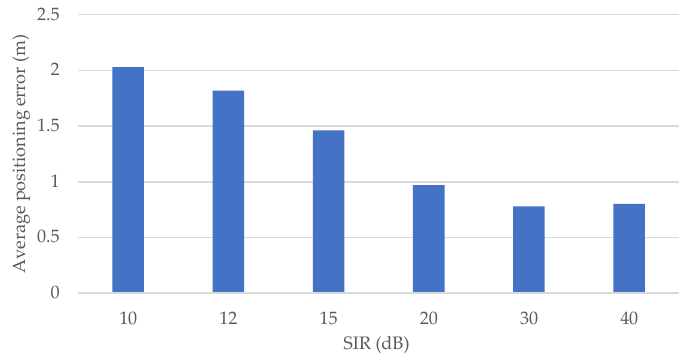
Figure 17. Average horizontal positioning error for each SIR.